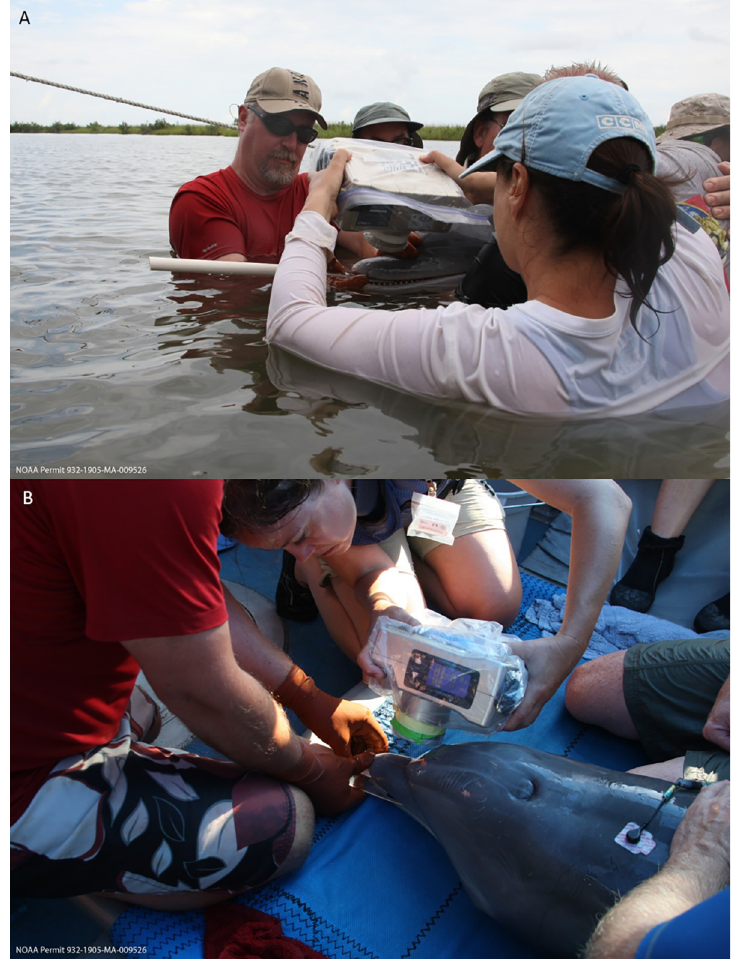
Fig 2. Periapical dental X-ray procedure on wild bottlenose dolphins. During health assessments, water-proofed, portable X-ray equipment was used to collect lateral views of the maxillary or mandibular teeth, both while dolphins were held in the water (A) or evaluated on a processing vessel (B). The lead handler positioned the film holder, while the two other handlers closest to the head helped minimize side-to-side head movements. The individuals appearing in Fig 2 have given written informed consent (as outlined in PLOS consent form) to publish this